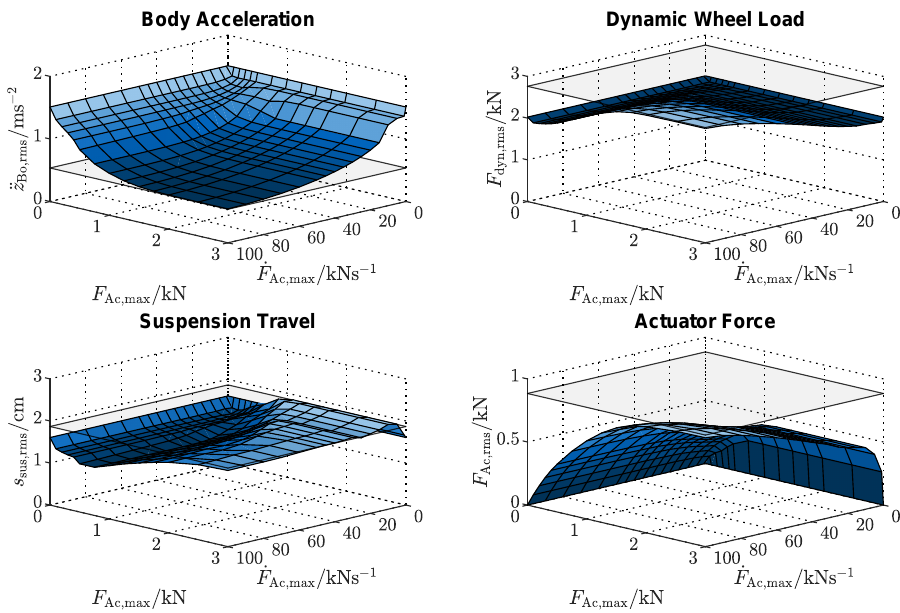
Figure 16. RMS surface plots for the 90kmh − 1 BC profile